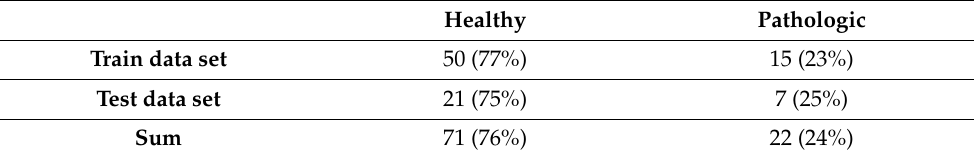
Table 2. Training and test data